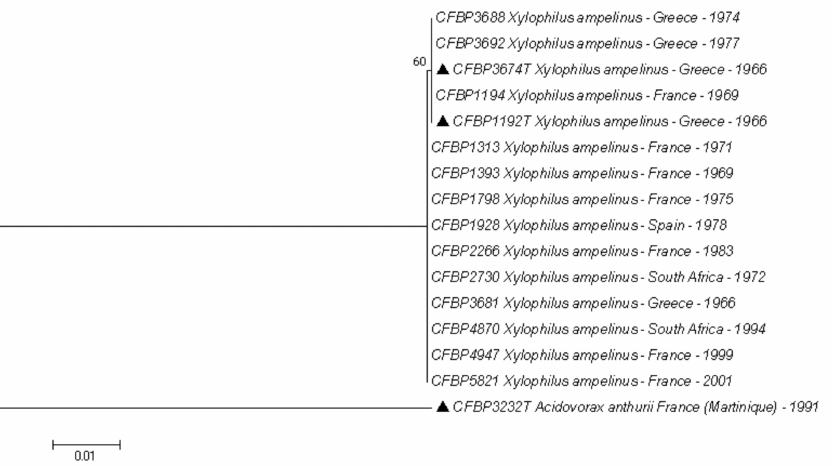
Figure 2. Phylogenetic tree reconstructed from concatenated partial sequences of gyrB and rpoD housekeeping genes for 15 strains of Xylophilus ampelinus and the type strain of Acidovorax anthurii as outgroup. The phylogenetic tree was reconstructed with concatenated alignments of all genes with MEGA 7.0.26 using the neighbor-joining method with 1000 bootstrap replicates, and the evolutionary distances were computed by using the Kimura two-parameter method. Triangles indicate the two CFBP accession corresponding ot the type strain (accession duplicated in the CIRM-CFBP collection). The phylogenetic tree of the 93 Xylophilus ampelinus strains and all accession numbers of the sequences are available in Figure S1 and Table S1,